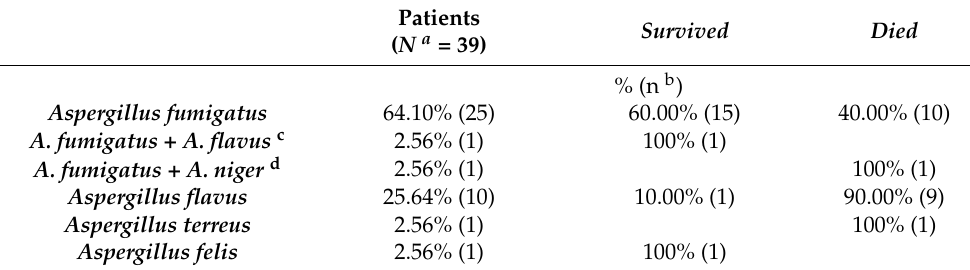
Table 8. Aspergillus species * identity and related mortality.